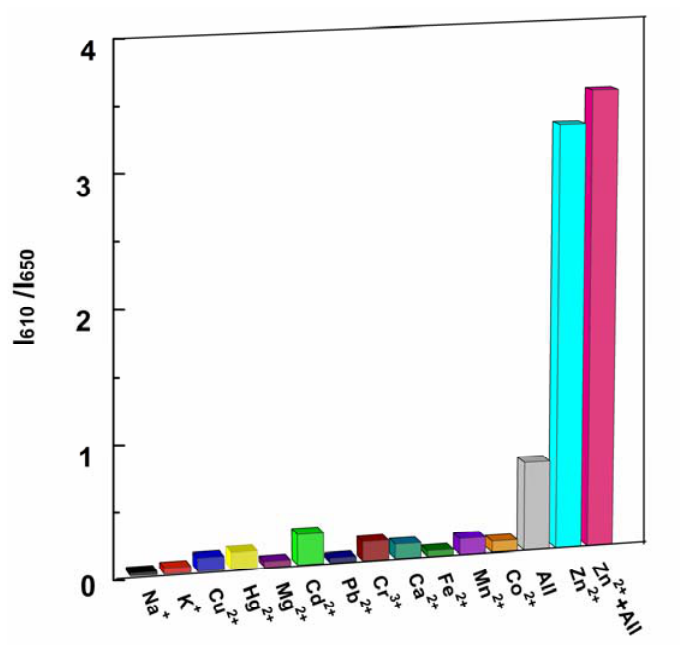
/I ) of P1 (10 μ M) at pH 7.4 to Zn 610 nm 650 nm